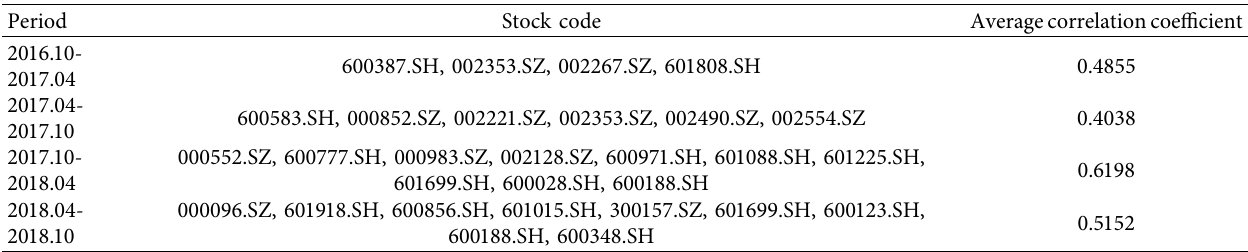
different ways to jump risk contagion in the energy industry.